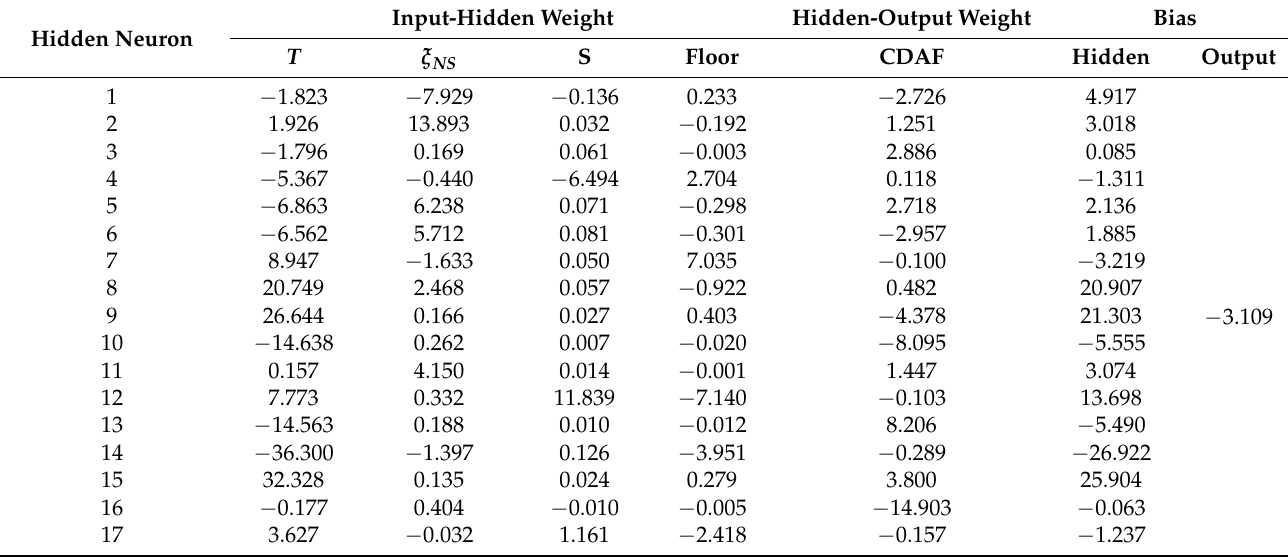
Table 8. Weights and biases of the ANN model for irregular